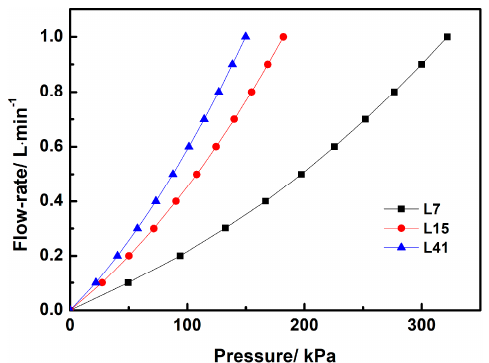
Figure 6. Nitrogen gas permeability of porous L-SiC ceramics with different particle sizes of initial coarse SiC powder.